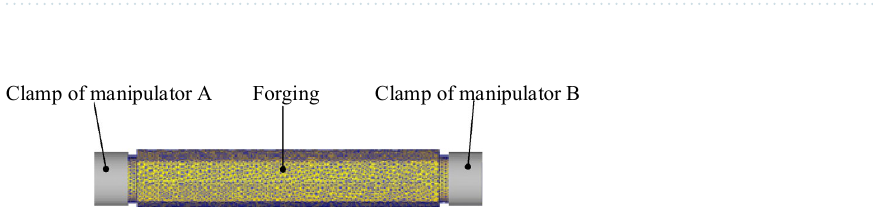
Table 2. Main parameters of the hydraulic system.